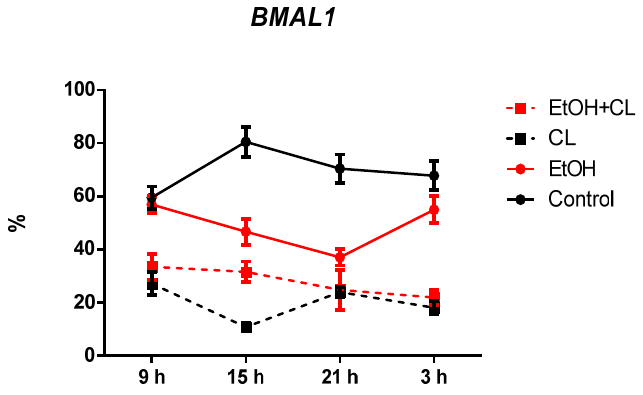
Figure 18. Daily dynamics of BMAL1 expression in hepatocytes of rats.